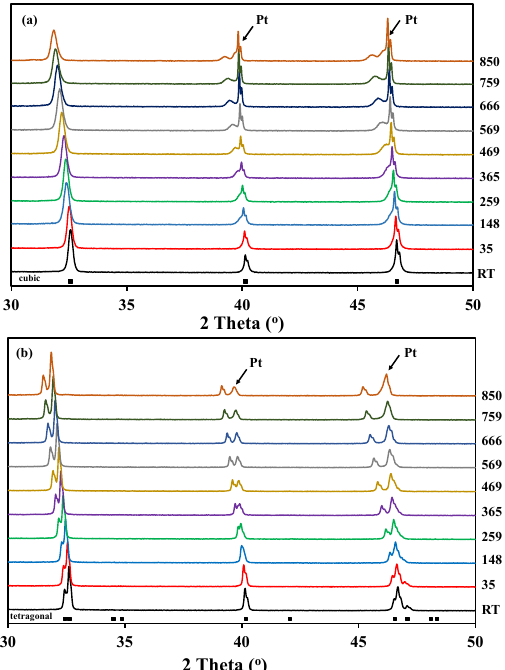
Figure 2. High temperature X ‐ ray diffraction patterns measured in pure O 2 from room temperature to 850 °C for:( a ) A ‐ site cation disordered La 0.5 Ba 0.5 CoO 3 ‐δ ; and ( b ) A ‐ site cation order and oxygen vacancy disordered LaBaCo 2 O 5+ δ . The Bragg reflections for both cubic and tetragonal cells are included at the bottom.